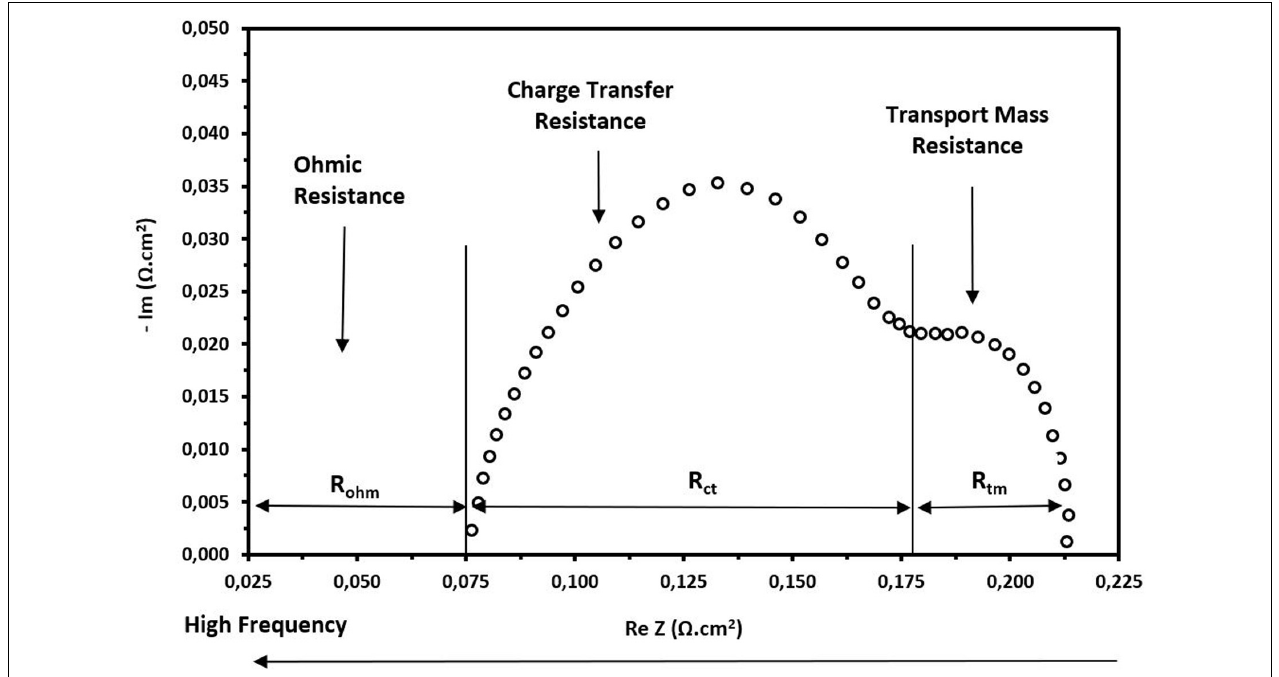
FIGURE 4 | Scheme for the interpretation of internal resistances in the Nyquist diagram. Frequency is evaluated in an increasing manner from the right to the left.